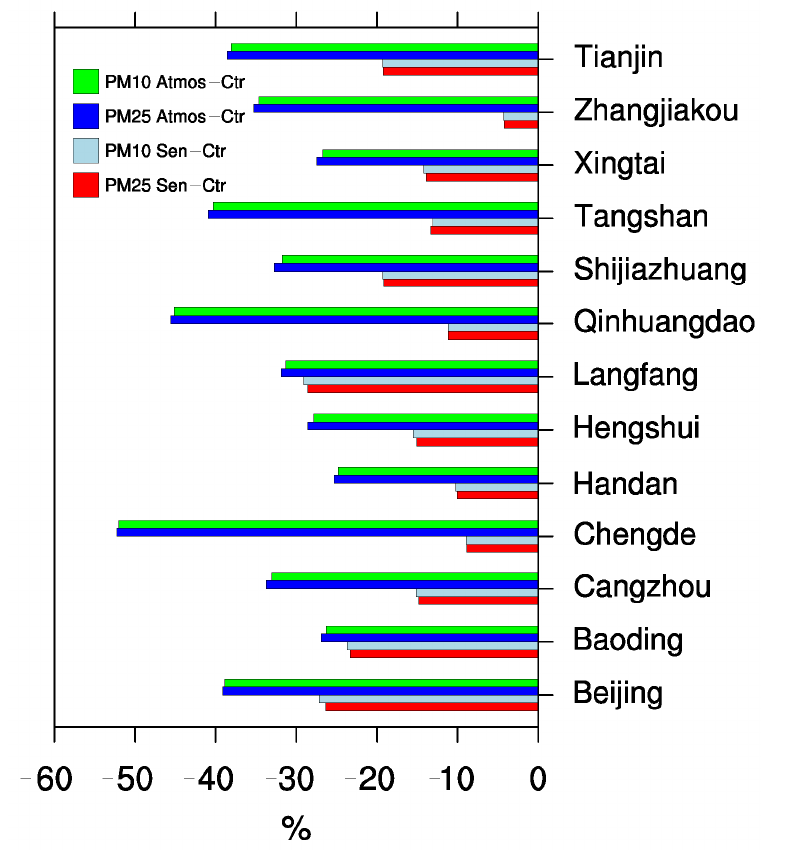
Figure 7. The change rates between spatially integrated concentrations of PM 2.5 and PM 10 (units: µ g/m 3 ) among each city based on the Base case and its difference with Sen_coal and Sen_2019 cases.